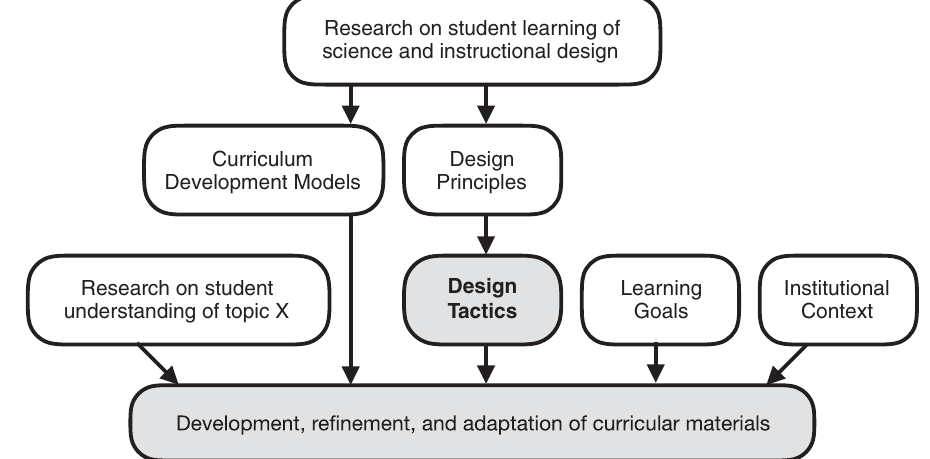
FIG. 1. A model for how design tactics fit within curriculum development. Vertical placement roughly corresponds to the level of abstraction (e.g., curriculum development models are more abstract than learning goals) and arrows represent how the elements impact the curricular materials (e.g., research on learning of topic X can impact development more directly than broader research which is typically mediated through curriculum development models and design